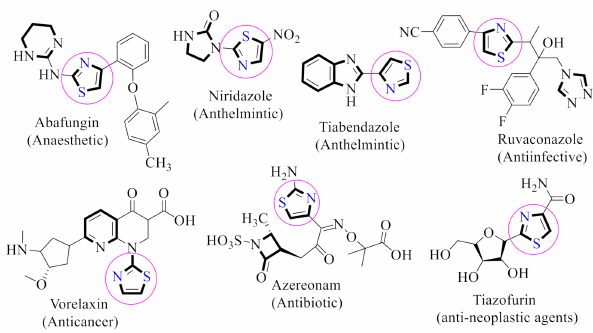
Figure 2. Bioactive drugs with a thiazole